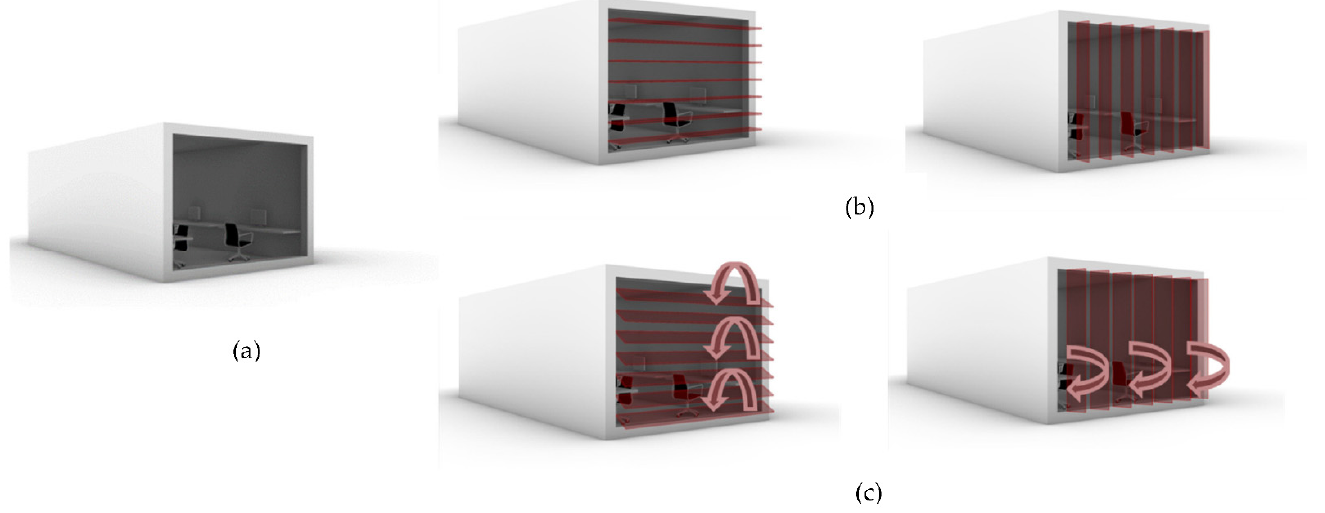
Figure 2. The three design scenarios. ( a ) No shade/no louvers. ( b ) Fixed louvers with zero-degree angle. ( c ) Responsive louvers with hourly optimum angles.